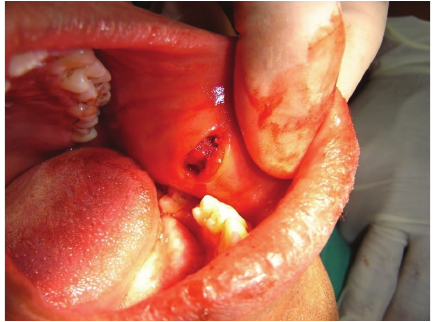
Figure 1: Surgical site after removing the parasite.